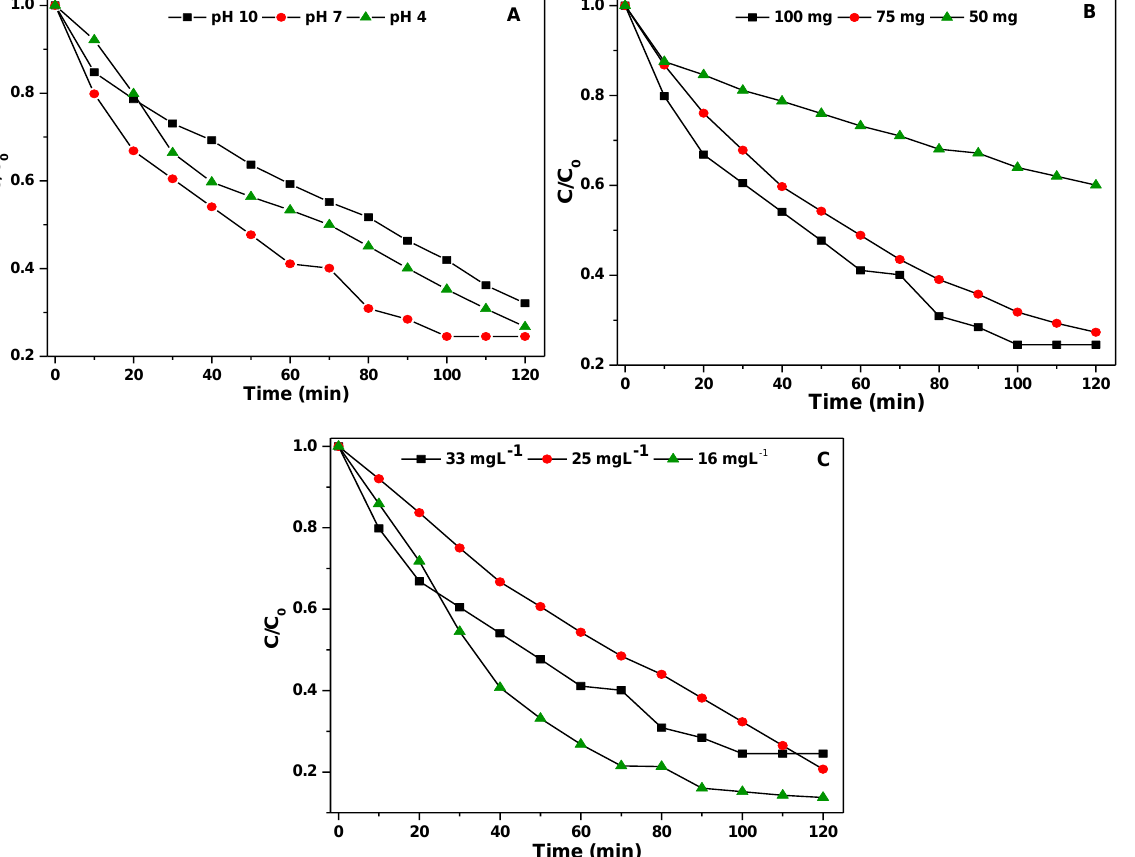
Ag-5 (B) Figure 8. ( A ) Photocatalytic efficiency ( B ) percentage degradation of p -NP over synthesized Ag nano- materials under visible light. The preliminary photocatalytic activity measurements indicated that the Ag-4 sam- ple is highly active for degradation of p -NP among the synthesized Ag containing nano- materials; hence, it was chosen to study the influence of different reaction parameters un- der visible light. The first parameter is the pH of the p -NP solution; a different solution with a pH of 4, 7, and 10 were used for the experiments by keeping the reaction tempera- ture (25 °C), mass of Ag-4 catalyst (100 mg), and p -NP concentration (33 mg·L −1 ) constant. The effect of pH on p -NP degradation was studied by adjusting the pH with dilute HNO 3 (0.1 M) or NaOH (0.1 M) solution. The pH plays an important role in the adsorption or